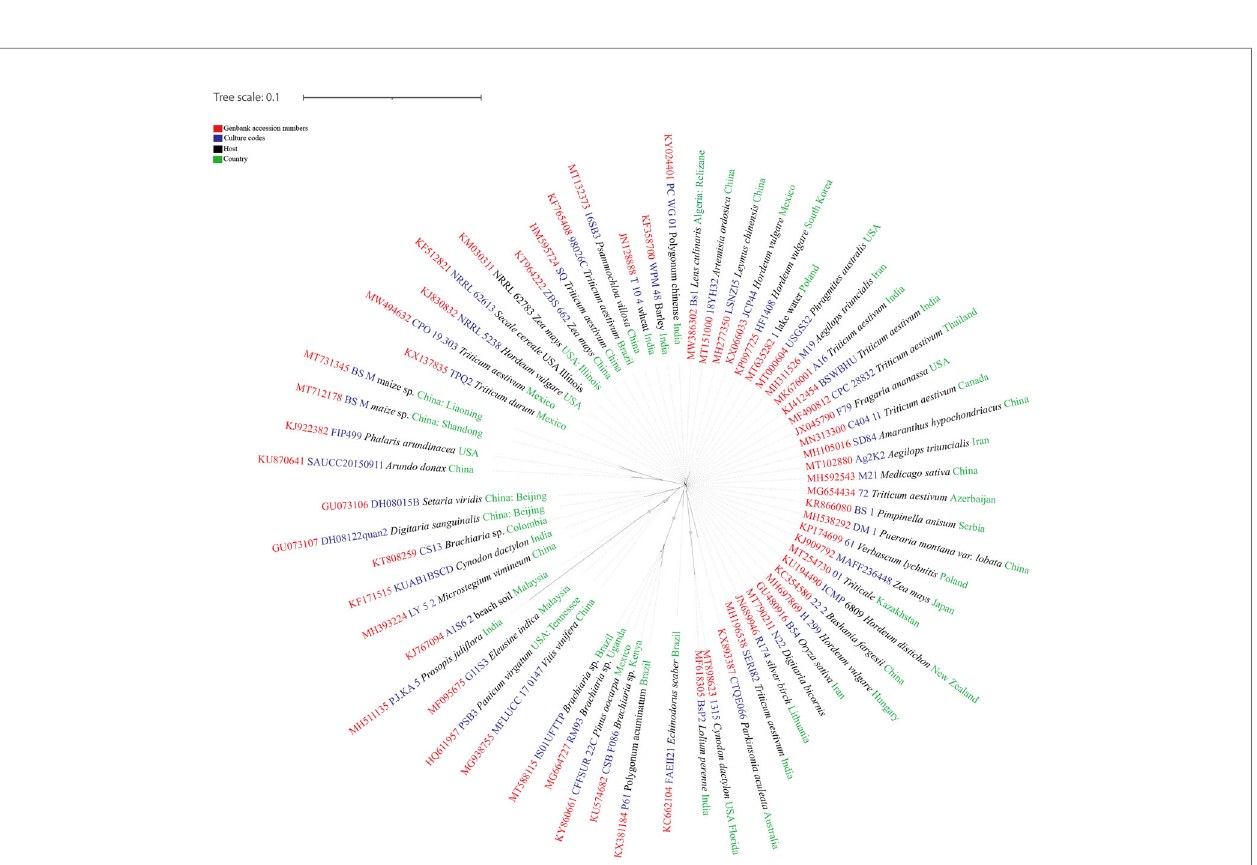
FIGURE 5 | The unrooted RAxML bipartion unrooted phylogenetic tree of Bipolaris sorokiniana built from sequences retrieved from NCBI